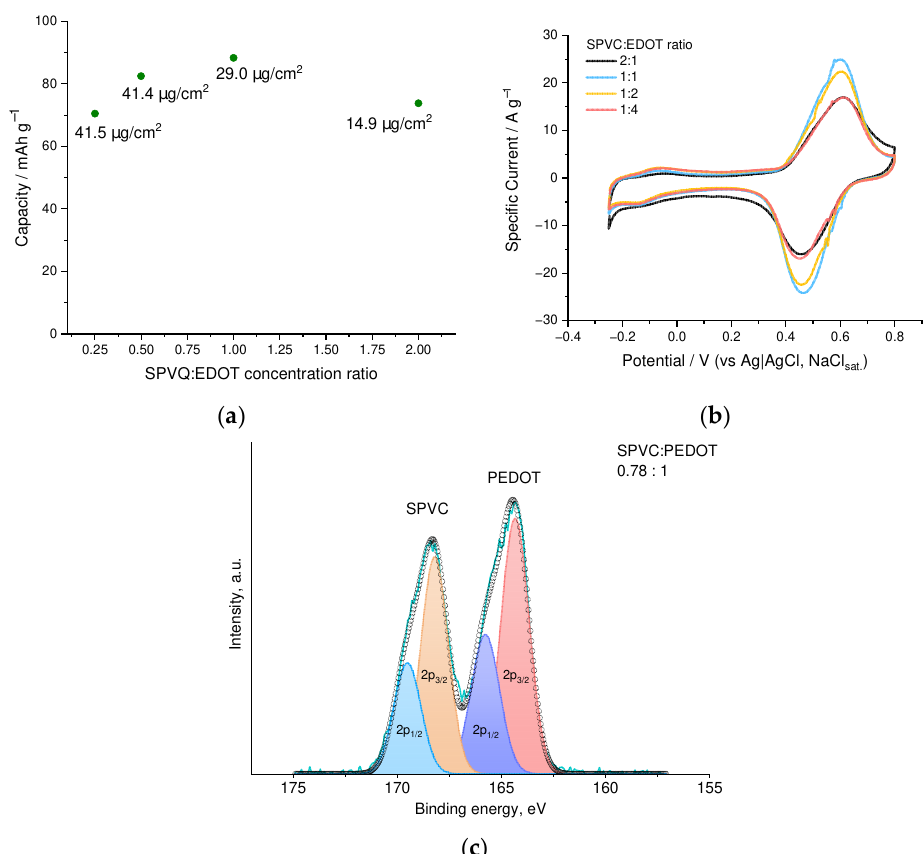
Figure 5. ( a ) Gravimetric capacity and areal loading vs. NaSPVC:EDOT molar ratio in the deposition electrolyte, ( b ) CV curves (20 mV·s −1 , 0.1 mM HClO 4 /H 2 O) of PEDOT:SPVC films deposited from EDOT + NaSPVC solutions with different molar ratio and ( c ) fitted XPS spectrum of the PEDOT:SPVC deposited from 1:1 solution; deposition from 20% CH 3 CN in H 2 O.